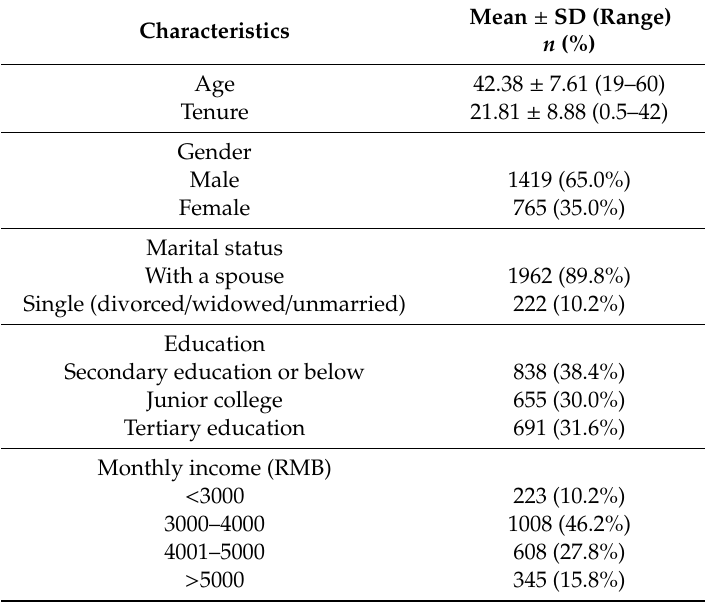
Table 1. Sociodemographic characteristics of the